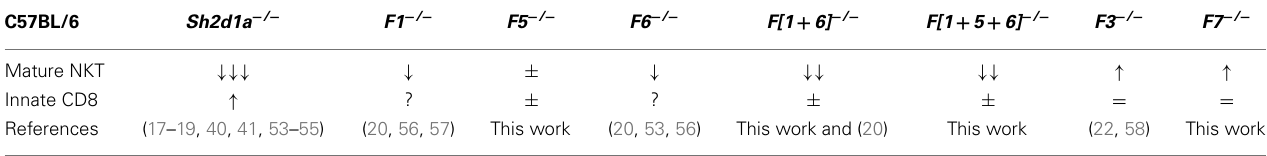
Table 2 | Effects of SAP and SLAMF receptor deficiencies on innateT cell development in the thymus of B6 mice.